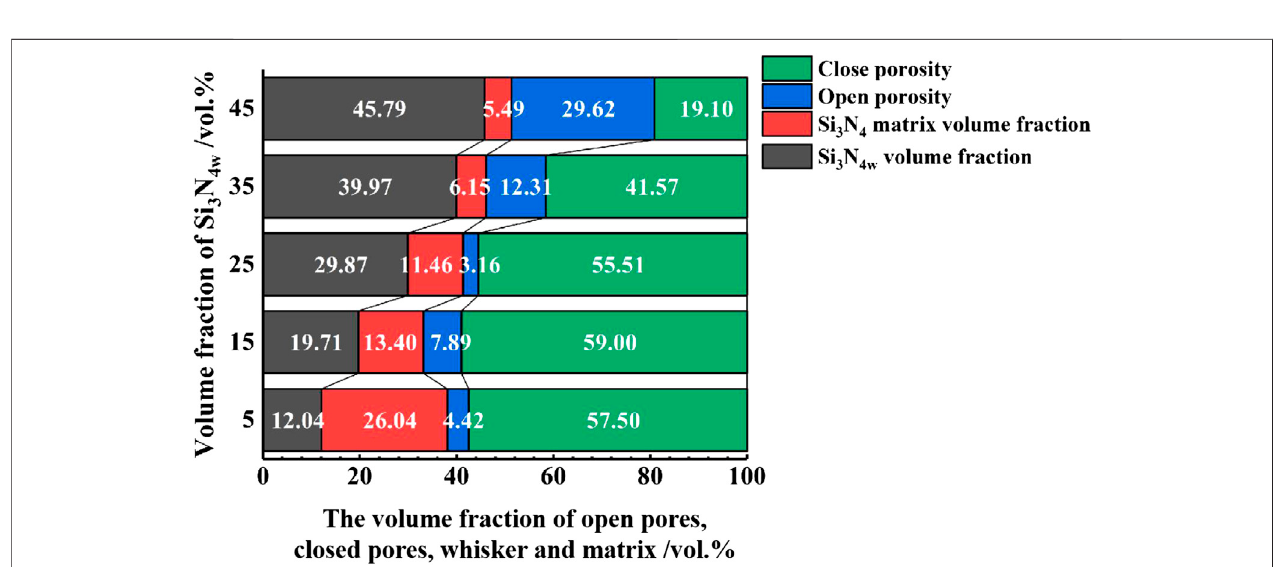
FIGURE 6 | The volume fraction of open pores, closed pores, whisker, and matrix/vol%.